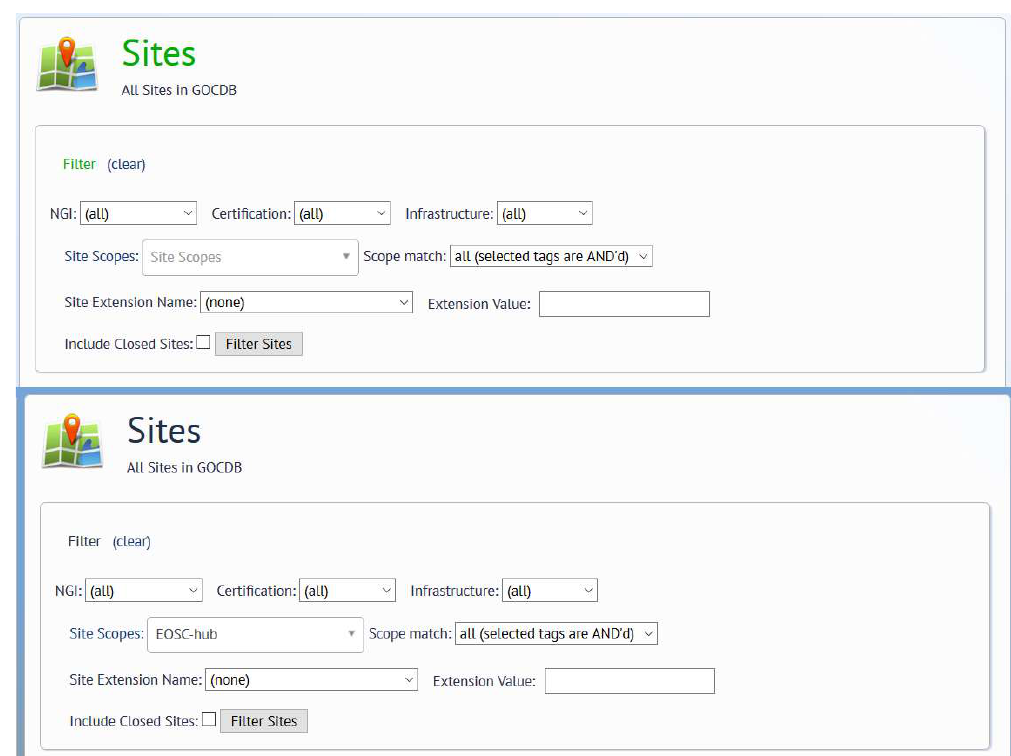
Fig. 4. The traditional, unfiltered view of sites in GOCDB (top) and the pre-filtered view of sites provided by the EOSC-hub scope specific